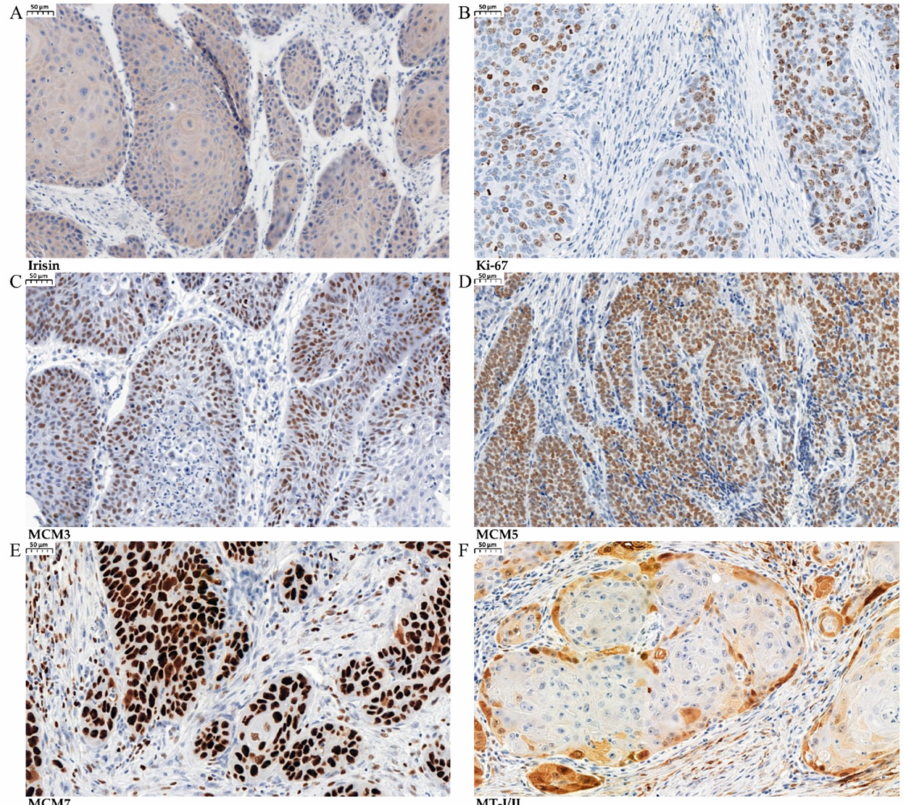
Figure 3. Immunohistochemical (IHC) reactions (brown) indicating irisin expression in the cytoplasm in laryngeal squamous cell cancer (LSCC) ( A ) with antigen Ki-67 ( B ), MCM3 ( C ), MCM5 ( D ), MCM7 ( E ), and MT-I/II ( F ) in LSCC (magnification ×